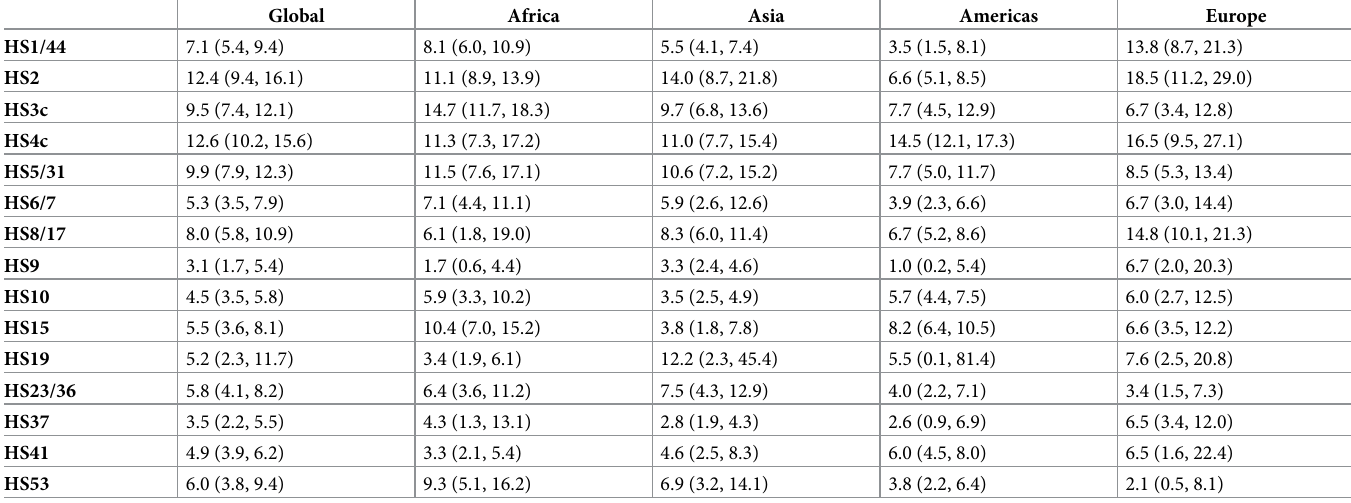
Table 2. Global and regional pooled prevalence (95% confidence intervals) of 15 C . jejuni capsule types among all typable C . jejuni